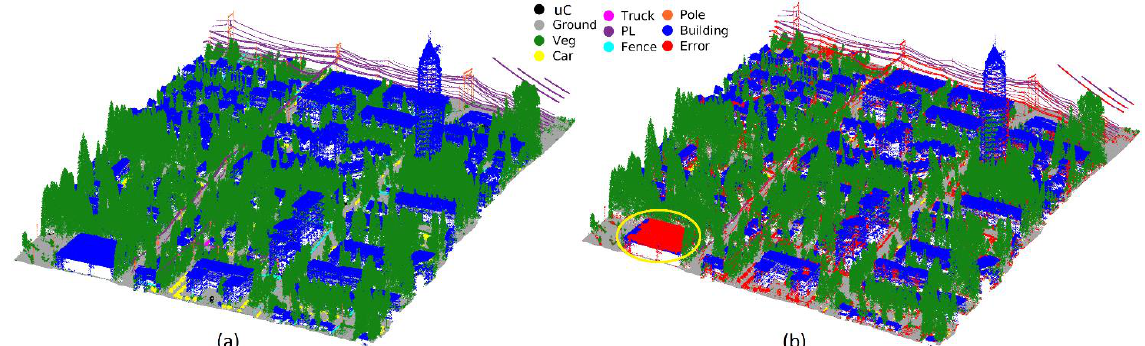
Figure 5 . (a) DALES test dataset with ground-truth point labels, and (b) semantic segmentation results for the test dataset, including error (false negative, red).